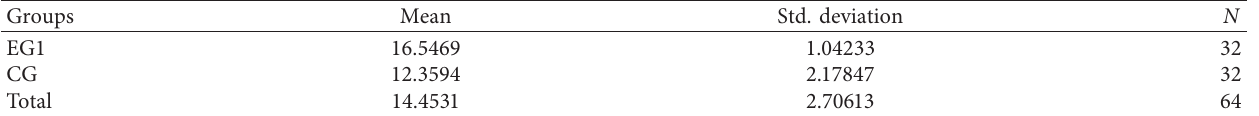
Note . EG (Experimental group); CG (control group). Table 2: Descriptive statistics for comparing the posttest scores of the EG1 and CG learners. Groups